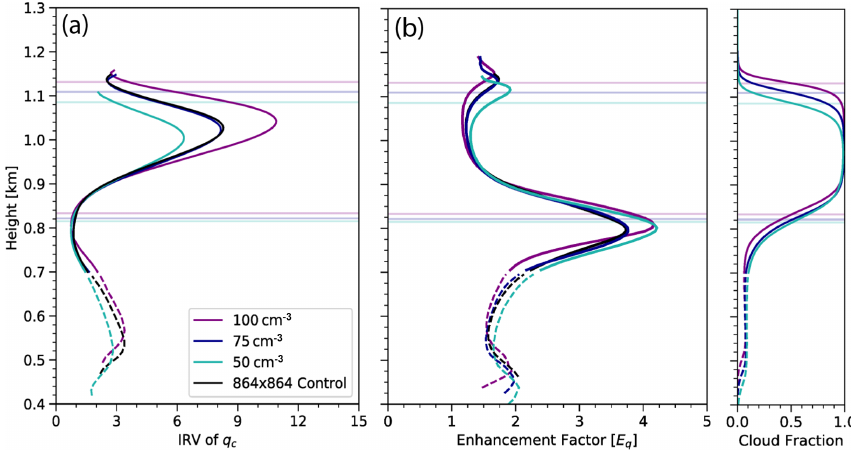
and (b) enhancement factor E q . Solid lines represent total Figure 10. Vertical profiles of the horizontally averaged (a) inverse variance ν q c values, whereas dashed lines represent values correlating to only cumulus clouds. Purple, dark blue, and teal lines represent simulations with N c values of 100, 75, and 50cm − 3 , respectively, all run over the smaller 256 × 256 (8 . 96 × 8 . 96km 2 ) grid. The black lines correspond to the control run using the larger domain and an N c value of 75cm − 3 . The colored lines correspond to cloud base and height, as in Fig.